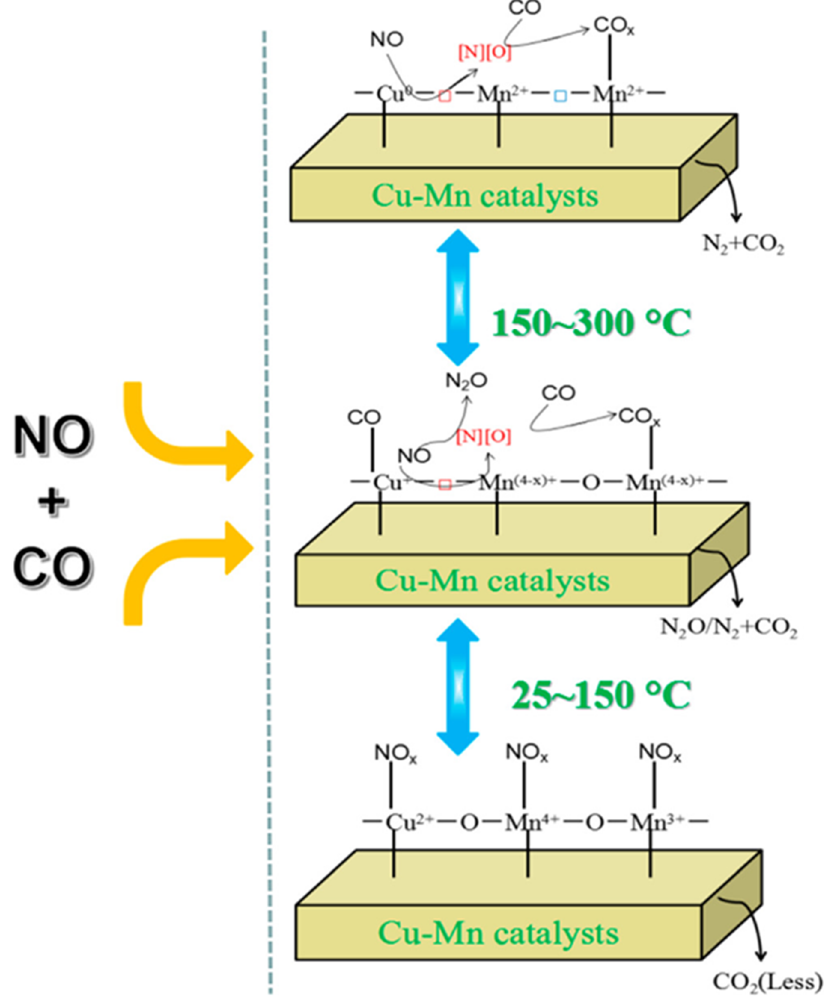
Figure 5. The mechanism of NO reduction with adsorbed CO on Cu–Mn–spinel catalysts (reproduced from [32]).